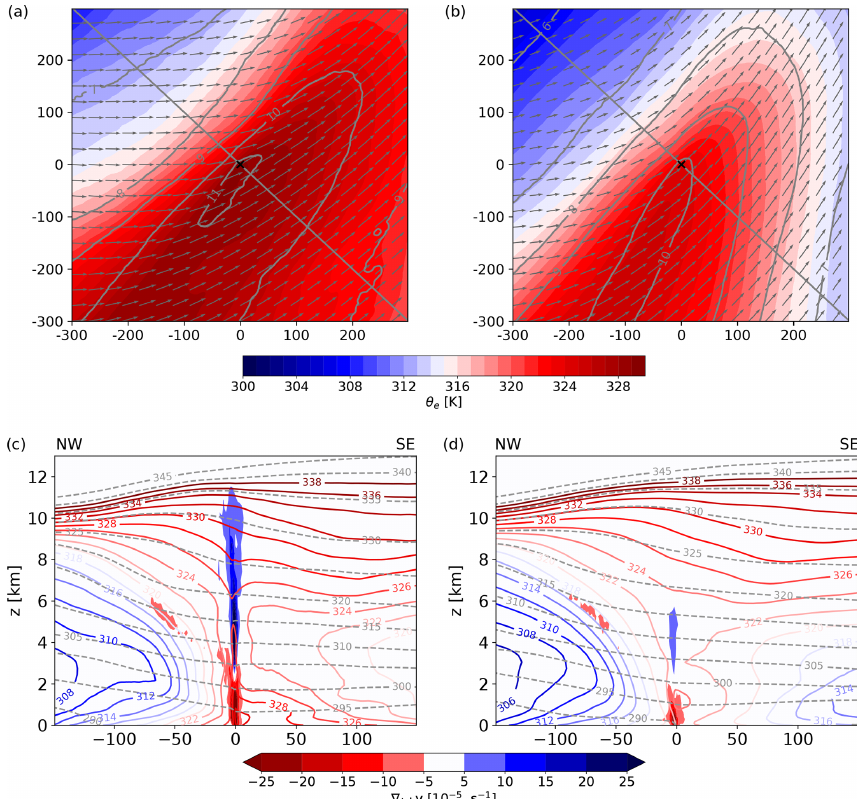
Figure 6. (a, b) Horizontal cross section composites of θ e at 900hPa (colors, in K), specific humidity (grey contours, every 1gkg − 1 ), and wind at 900hPa (arrows) for (a) convective WCB trajectories and (b) slantwise WCB trajectories at the start of the fastest 400hPa ascent. The axes’ dimensions denote the distance from the WCB air parcel locations marked as “ × ” (in km). (c, d) Vertical cross section composite along the northwest–southeast orientated lines shown in (a, b) for horizontal wind divergence (colors, in s − 1 ), equivalent potential temperature ( θ e , red and blue lines, every 2K), and potential temperature ( θ , dashed grey lines, every 5K) for (c) convective and (d) slantwise WCB trajectories at the start of the fastest 400hPa ascent. The x axis denotes the zonal distance from the WCB air parcel locations (in